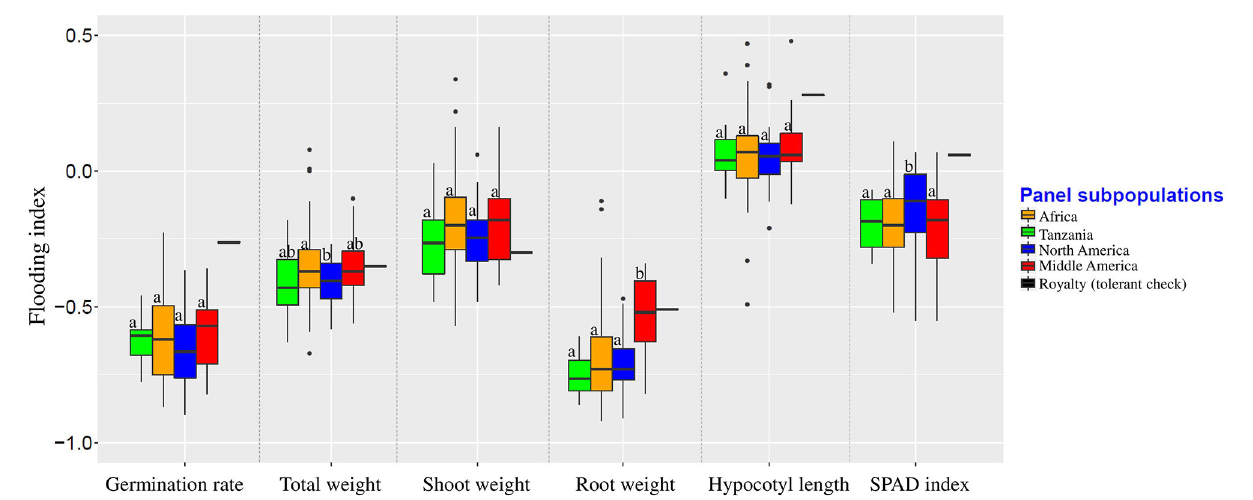
FIGURE 3 | Flooding indices of different subpopulations. Groups were color-coded based on the results of population structure plot ( K = 4, Figure 2 ). Boxplots indicated by the same letter for each trait are not significantly different at 0.05 probability level.